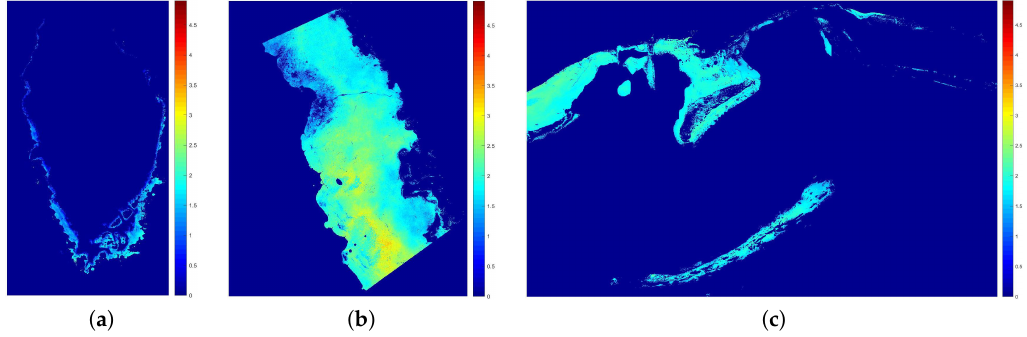
Figure 1. Images taken by the WorldView-2 satellite from ( a ) Saint Joseph Bay, ( b ) Keeton Beach and ( c ) Saint George Sound. The images were taken on 14 November 2010, 20 May 2010 and 27 April 2012, respectively. Selected sand, sea, land and seagrass regions are represented by cyan, blue, red and green boxes, respectively.